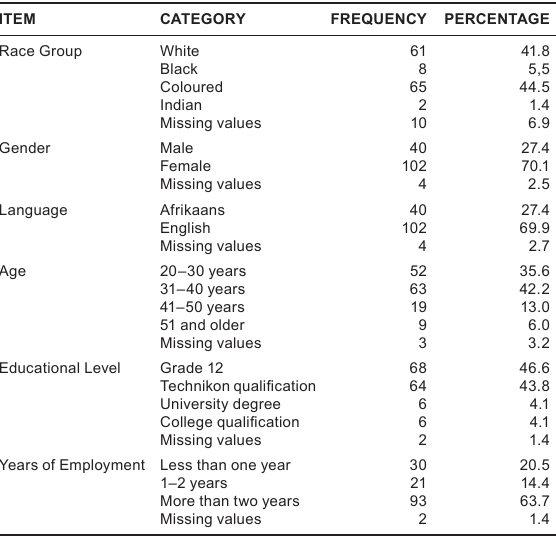
table 1 Characteristics of participants ( n =